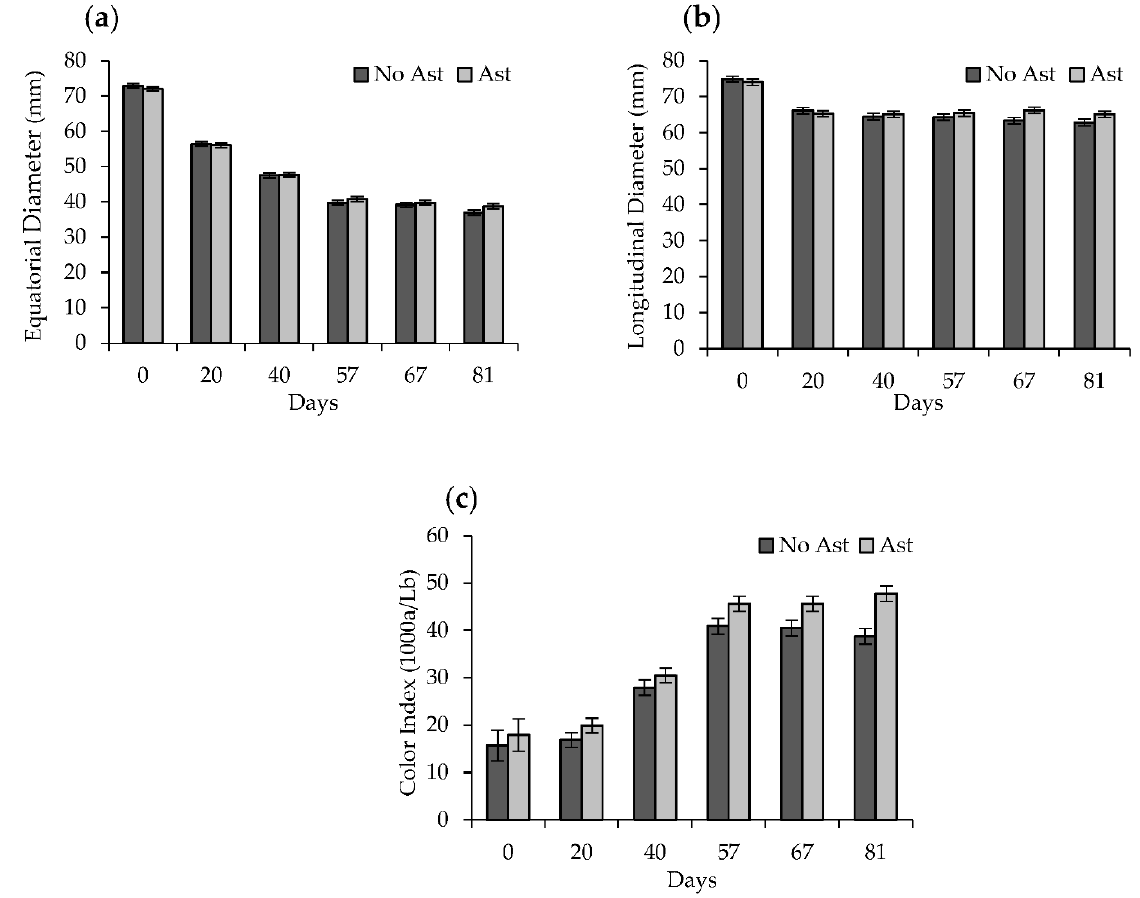
Figure 3. Equatorial diameter ( a ), longitudinal diameter ( b ) , and external color index ( c ) of the non-astringent (no Ast) and astringent (Ast) persimmon samples during the drying treatment. Bars represent the least significant difference (LSD) intervals ( p ≤ 0.05).